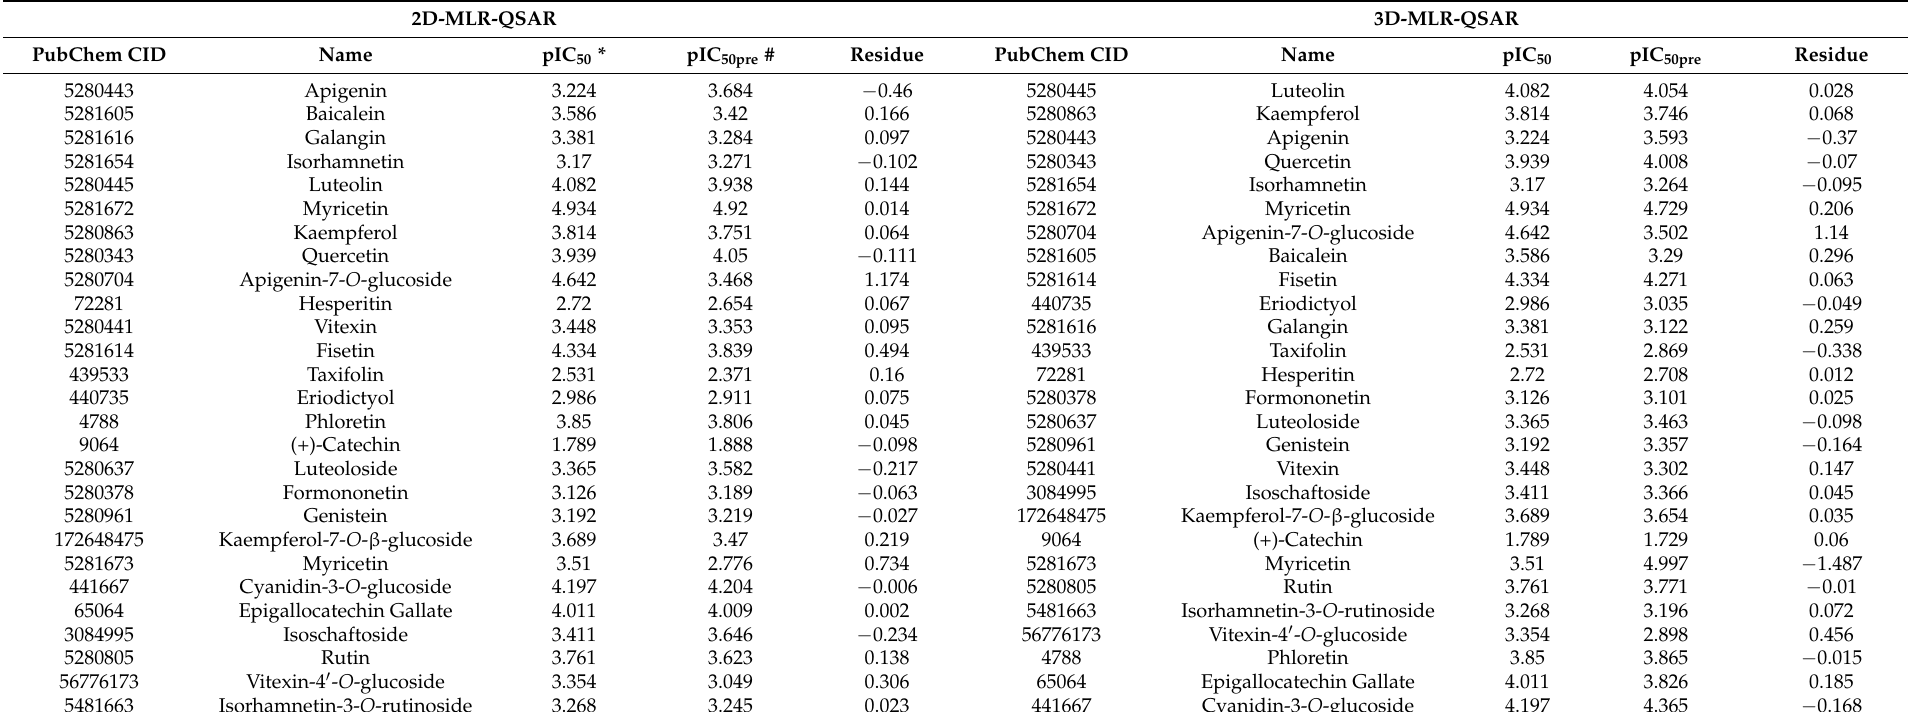
Table 1. Experimental and 2D- or 3D-MLR-QSAR predicted pIC 50 values for α -glucosidase-inhibitory activity of 27 dietary flavonoids.